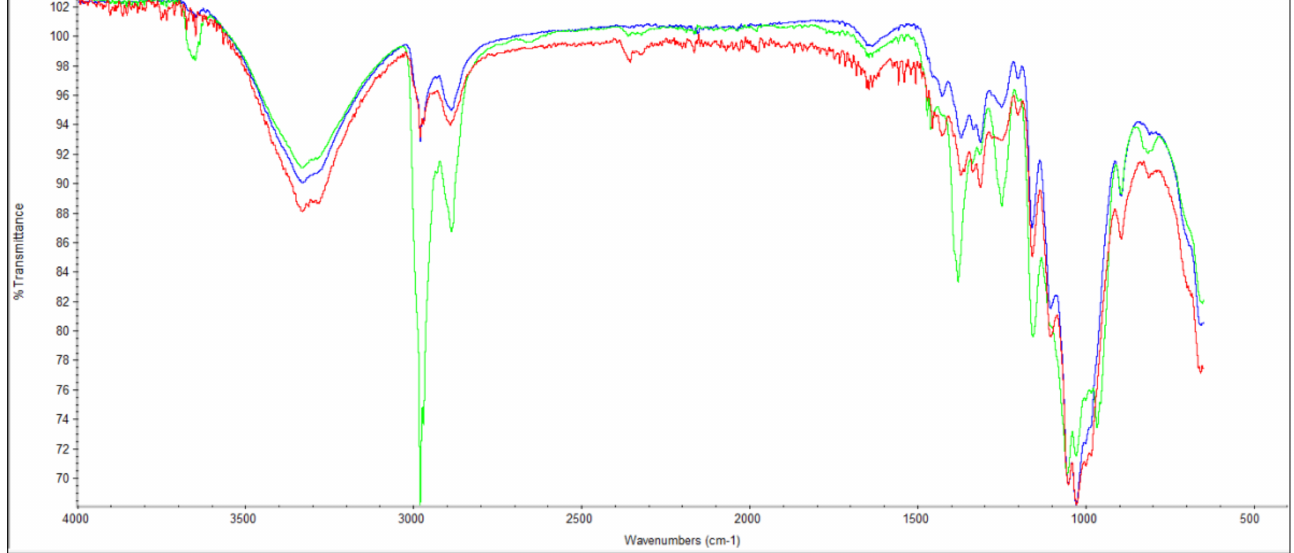
Figure 5. FTIR-ATR spectrum of formulation 1 (blue), formulation 2 (red) and formulation 3